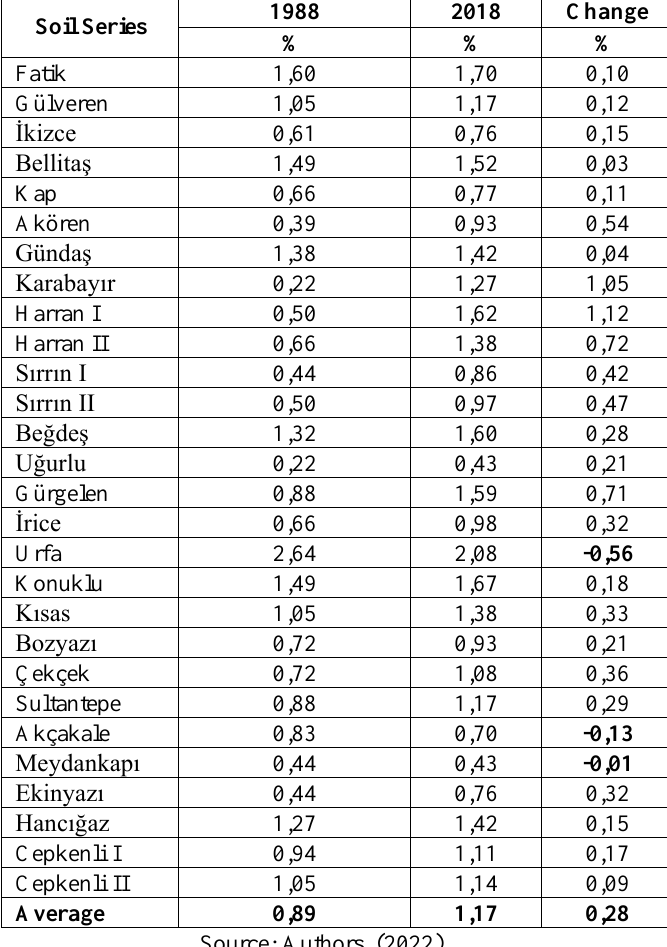
Table 2: The soil organic matter change from 1988 to